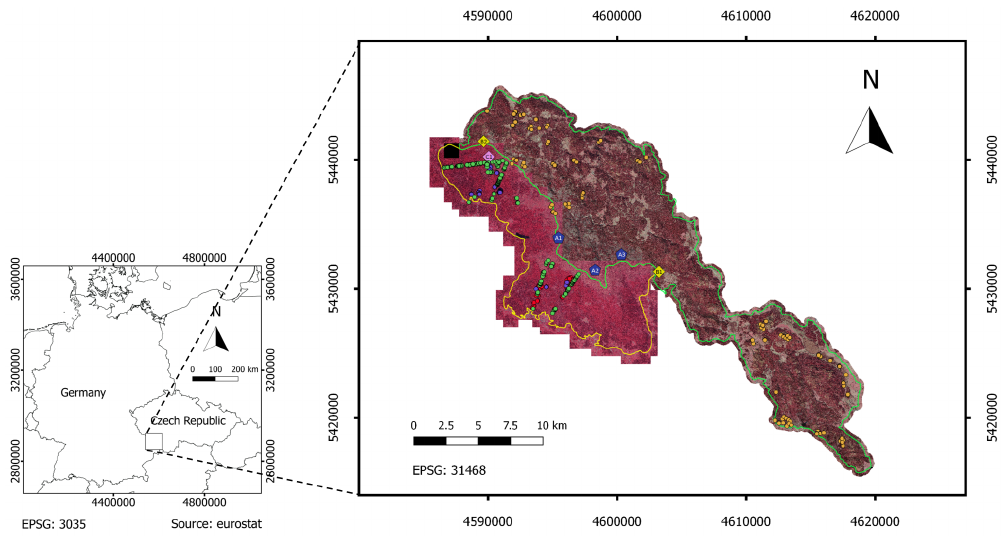
Figure 1. Map of Šumava National Park (green border) and Bavarian Forest National Park (yellow border) superimposed with orthophotos. Reference areas measured by field measurements: Bioklim CZ (orange circle), HTO (violet circle), Bioklim (green circle), LAI (red). Additional reference areas were manually labelled: A 1, A 2, and A 3 (blue pentagon) for dead trees and snags; B 1, B 2 (yellow diamond) and C 1 (purple diamond) for broadleaf trees and